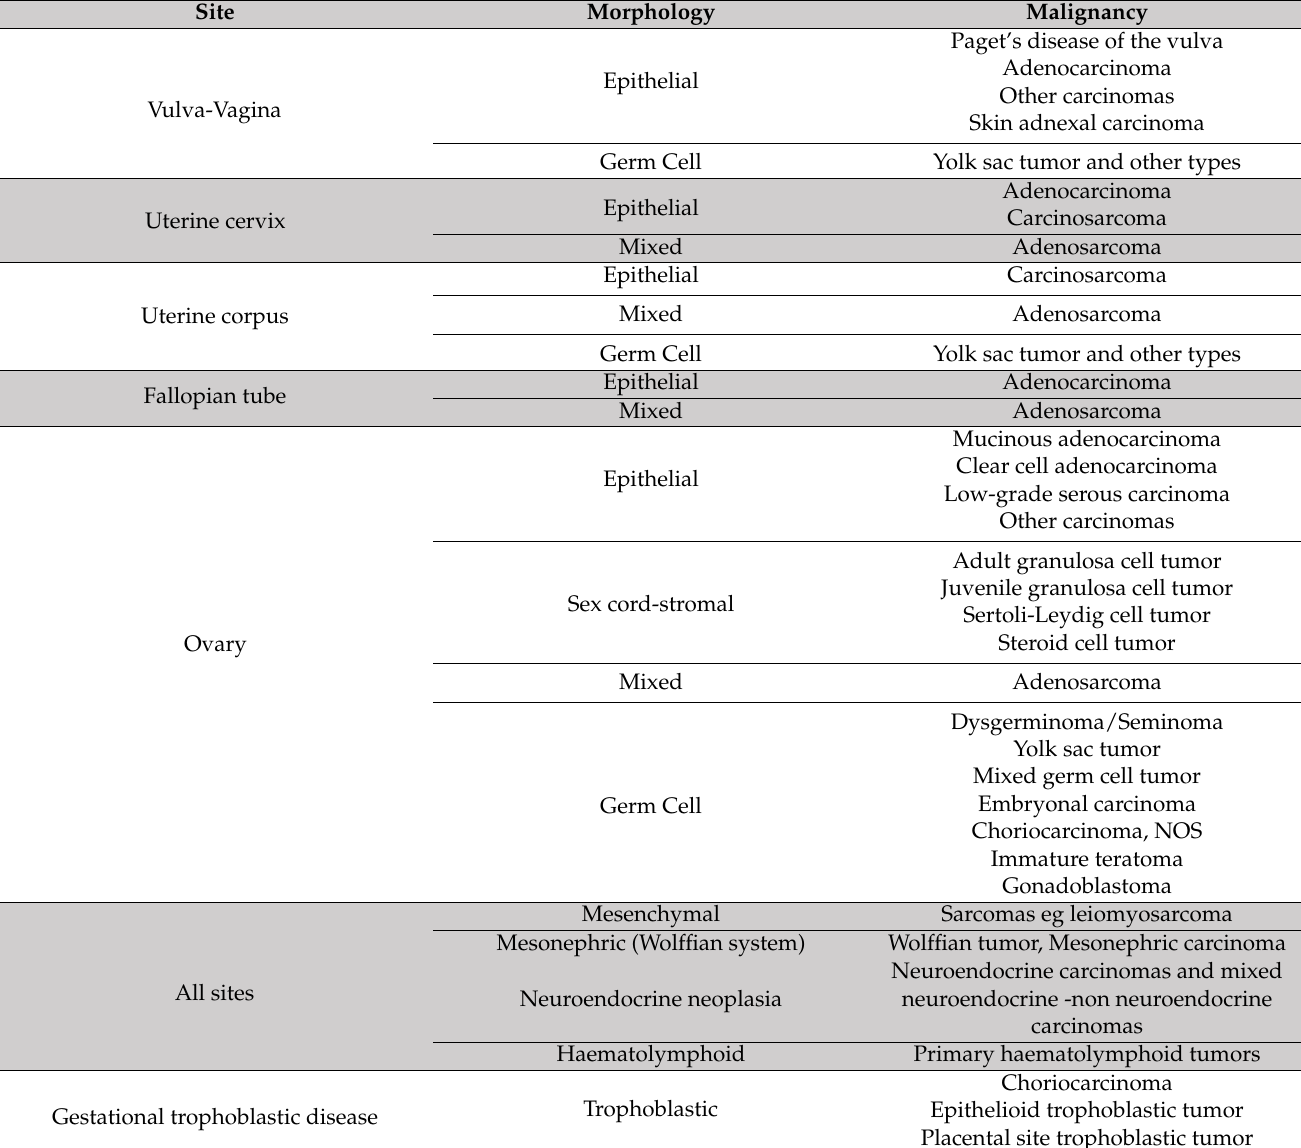
Table 1. Rare gynecological tumors